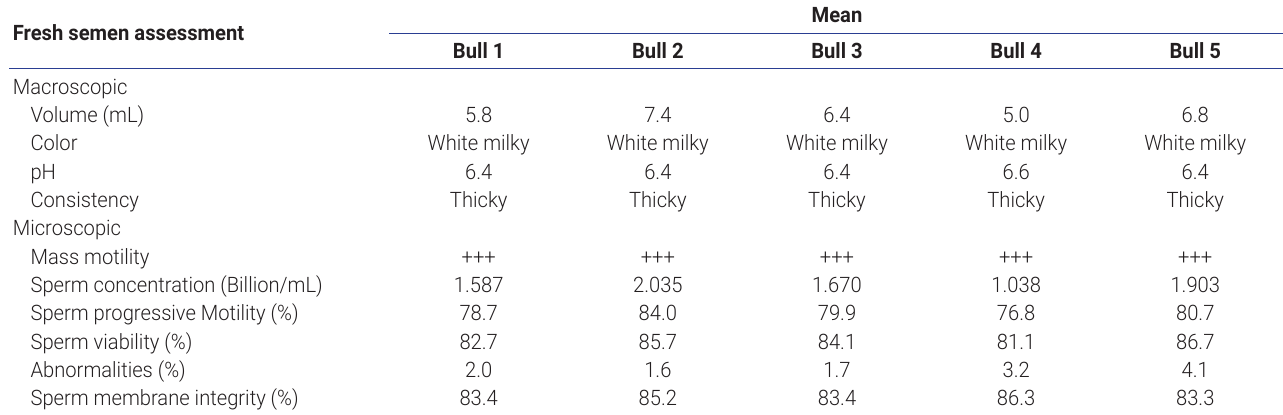
Table 1. Assessment of Bali bull’s fresh semen